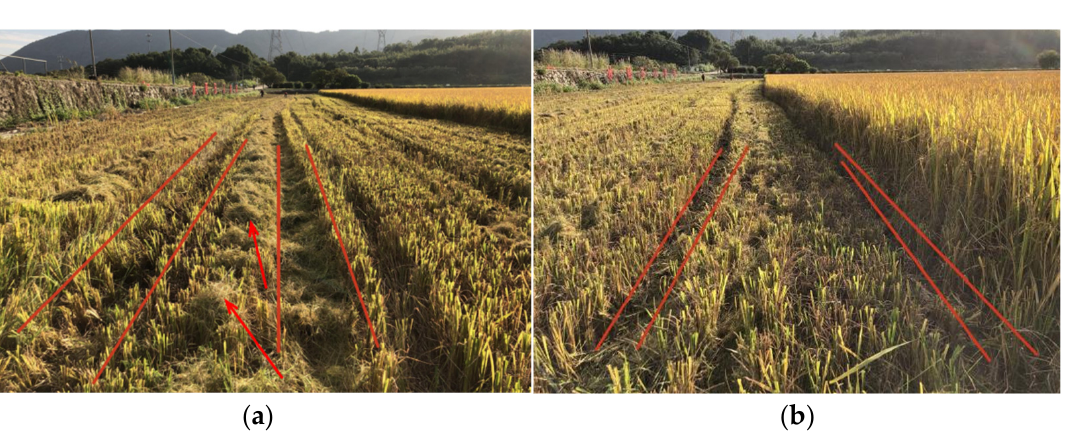
Figure 14. Comparison of rolling after harvesting: ( a ) rolling condition of control group and ( b ) rolling condition of ratooning rice harvester.